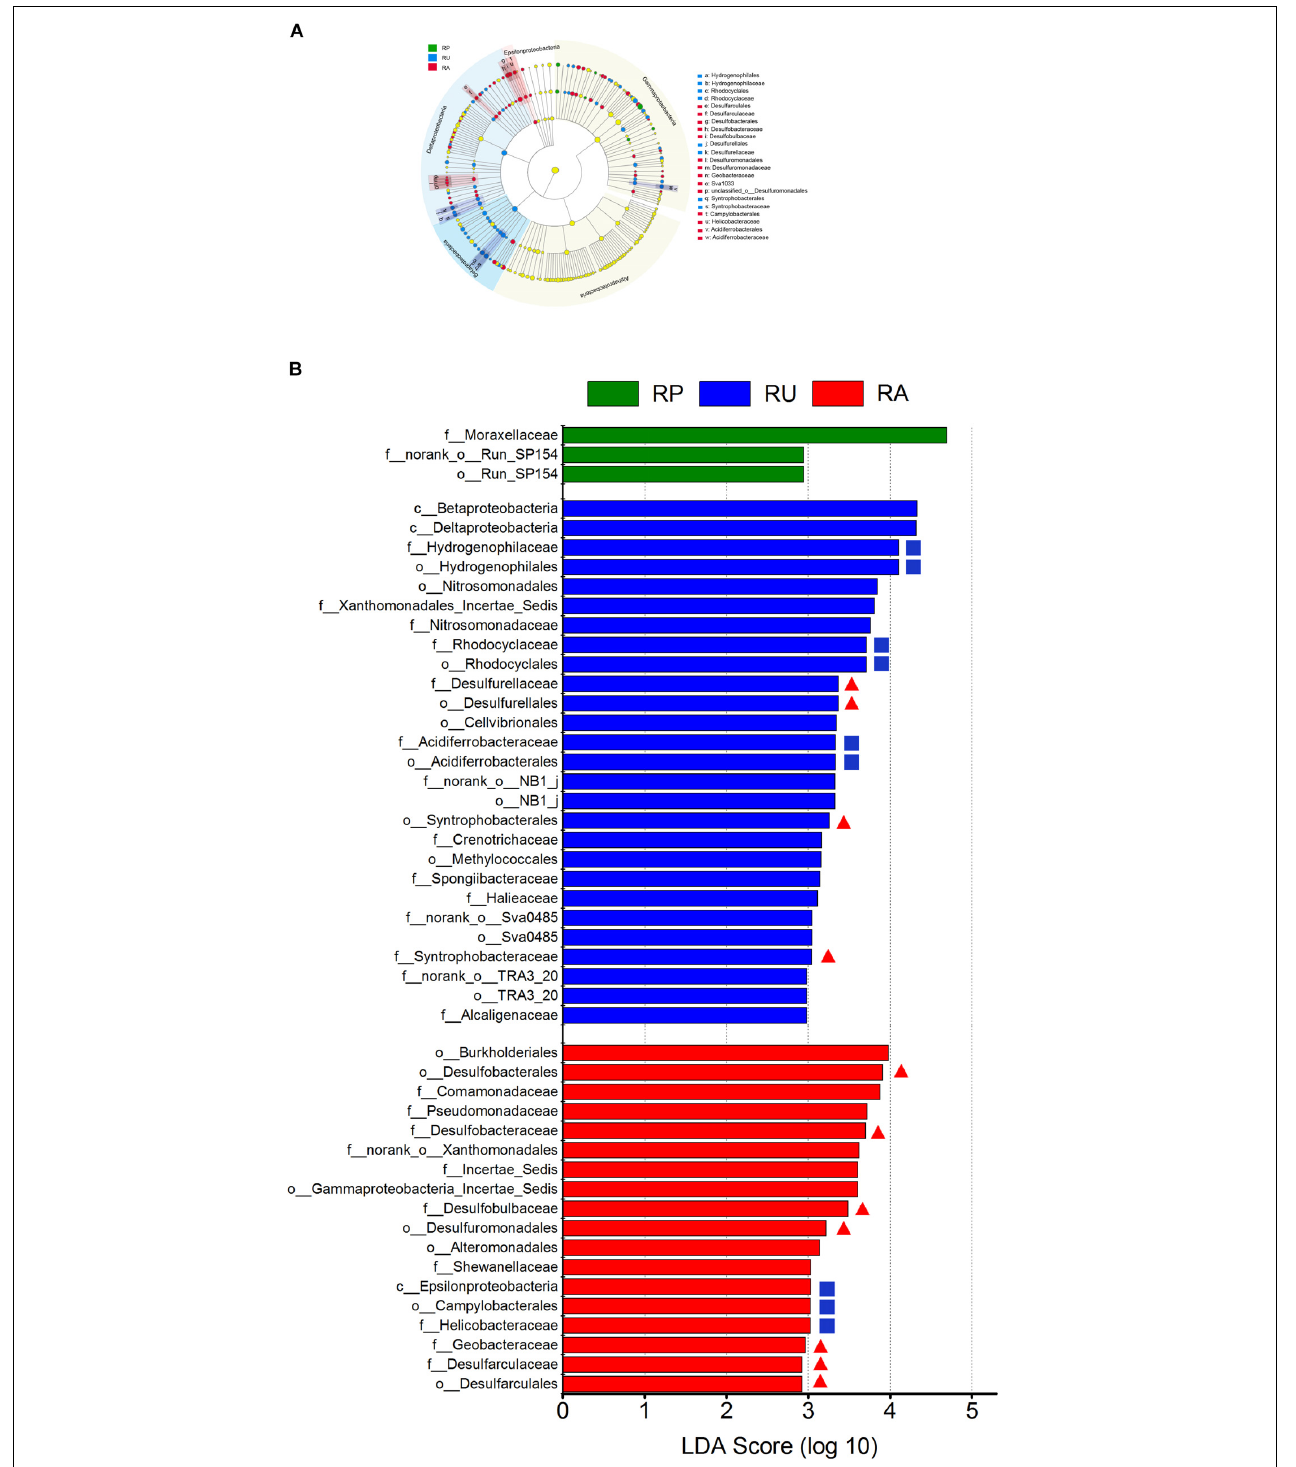
FIGURE 2 | Taxonomic differences among polluted and non-polluted regions by a linear discriminant analysis (LDA) coupled with effect size (LEfSe). (A) Taxonomic representation of statistically and biologically consistent differences among different regions. Differences are represented by the color of the most abundant class (green: RP; blue: RU; red: RA; and yellow: insignificant). The diameter of each circle is proportional to the taxon abundance. (B) LDA scores were calculated by the LDA effect size, using the linear discriminant analysis to assess the effect size for each differential taxon (green: RP; blue: RU; red: RA; red triangle: sulfate-reducing microorganisms; blue square: sulfur-oxidizing microorganisms). The microbial taxa with high LDA scores (rank 50) are visualized. n = 9 for each region. c__: class; o__: order; f__: family.